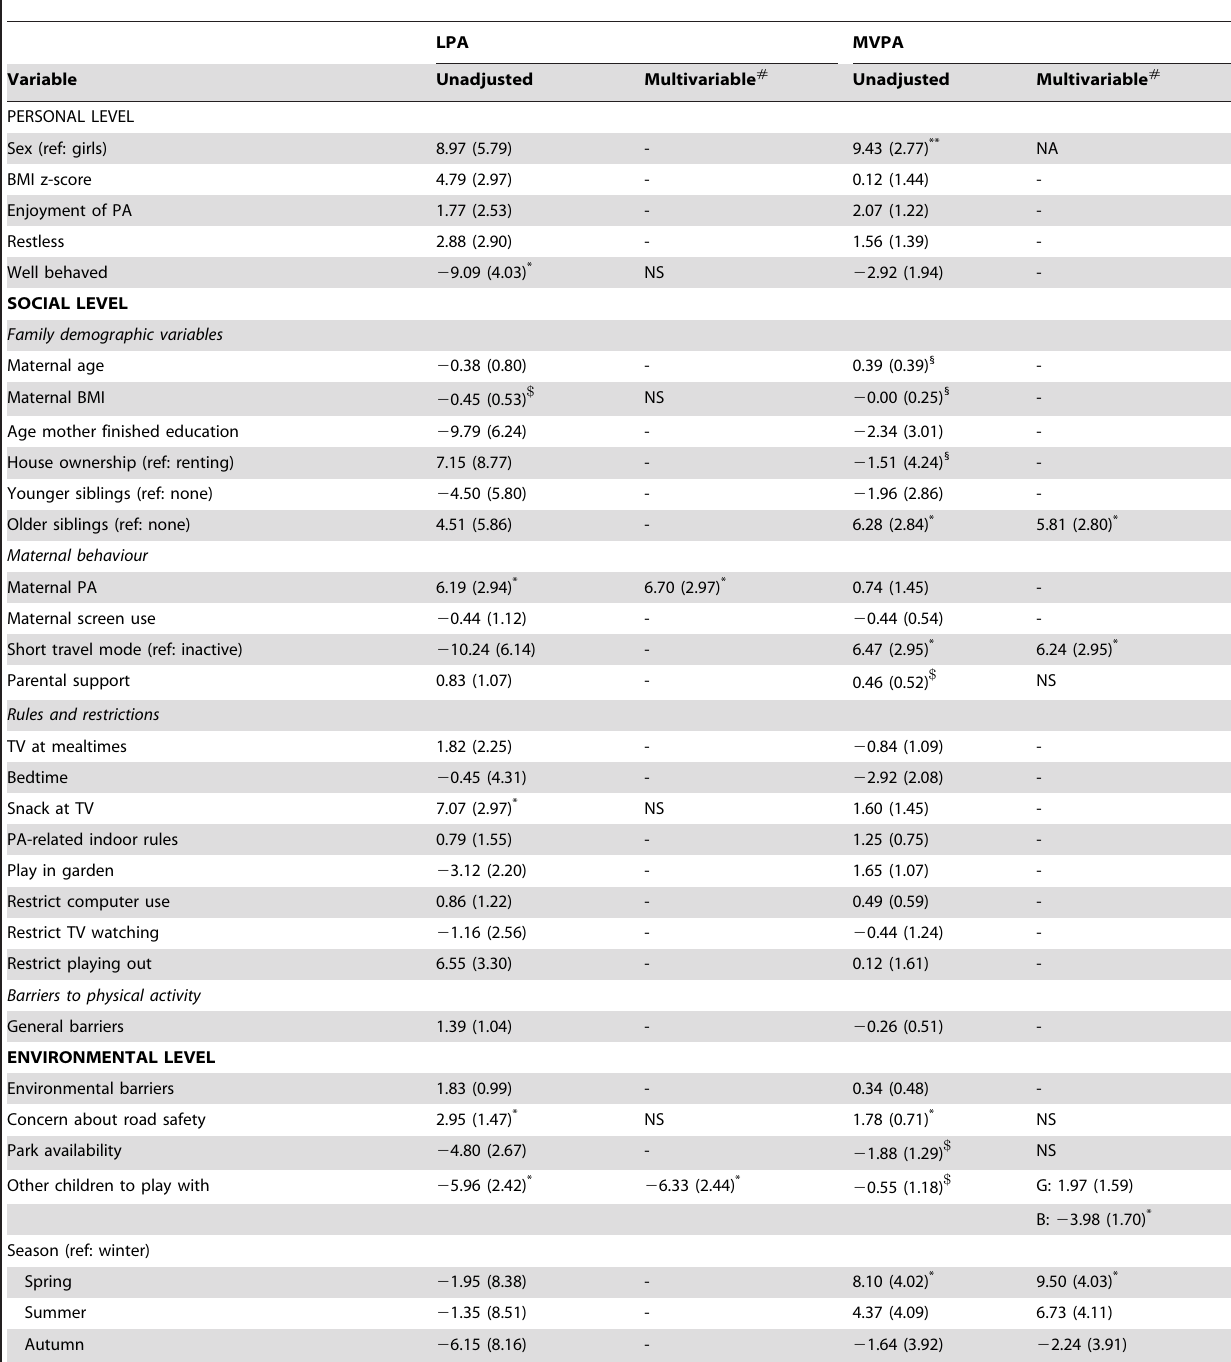
Table 2. Unadjusted and multivariable associations between potential correlates and four-year-old children’s light physical activity (LPA) and moderate-to-vigorous physical activity